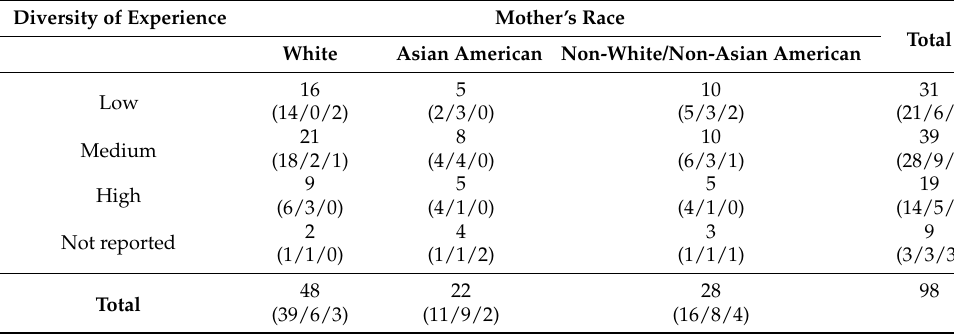
Table 1. Number of infants in each experience